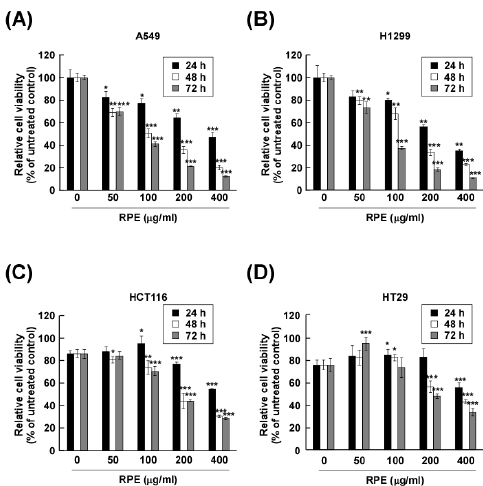
Figure 1. E ff ect of rose petal extract (RPE) on proliferation of human lung and colon cancer cells. ( A , B ) A549 and H1299 cells and ( C , D ) HCT116 and HT29 cells were treated with RPE at a concentration of 0, 100, 200, or 400 µ g / mL for 24, 48, or 72 h, and then a CCK-8 assay was performed. Relative cell viability is represented as means ± standard deviation ( n = 3) as * p < 0.05, ** p < 0.01, *** p < 0.005, compared with untreated group.